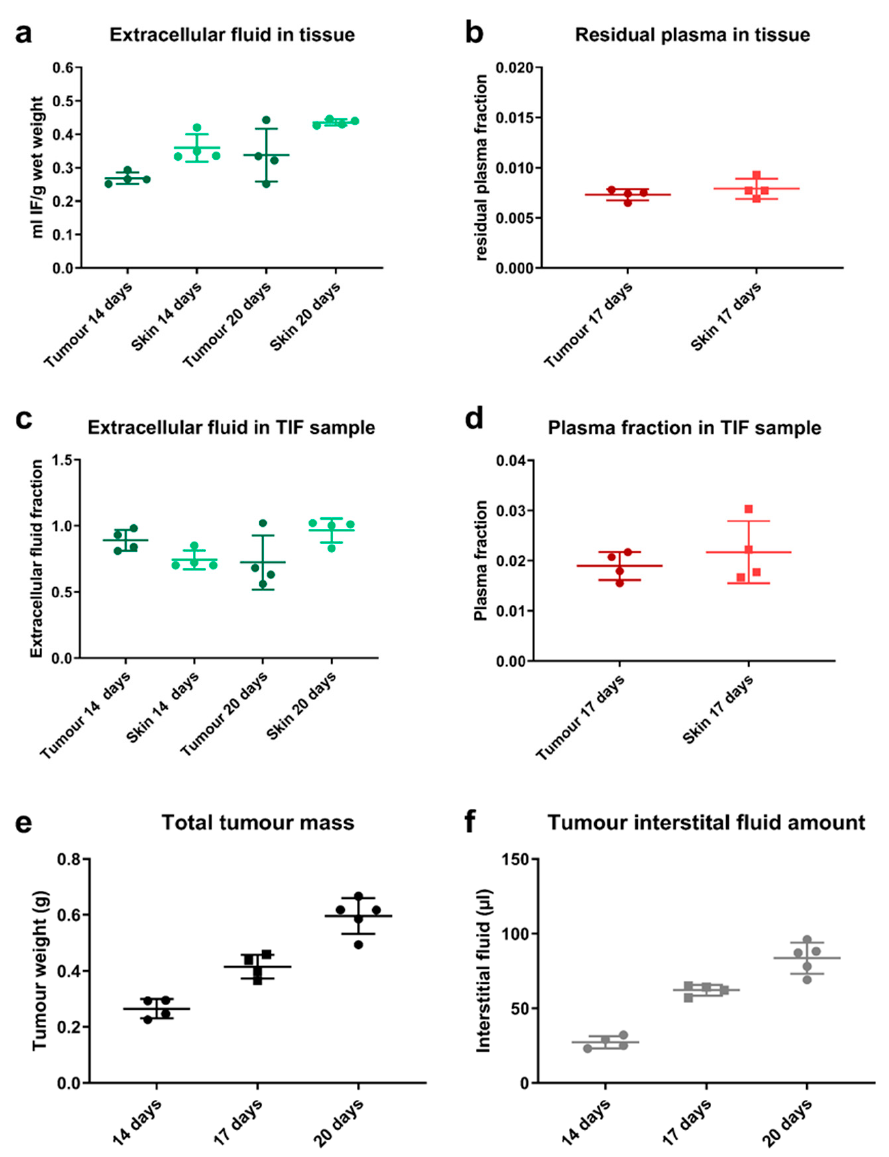
Figure 3. Composition of tissue sample and isolated fluid sample: ( a ) Extracellular volume fraction in tumour and skin sample as measured by 51 Cr-EDTA distribution (1 h after injection) in mice; ( b ) residual plasma volume fraction in harvested tumour and skin tissue as measured by 125 Iodine-HSA distribution (5 min after injection); ( c ) extracellular fluid fraction in the isolated fluid sample from centrifugation of skin and tumour samples and ( d ) plasma contamination, in terms of residual plasma volume fraction, in the isolated fluid sample after centrifugation; ( e ) weight of tumour samples harvested from mice at 14, 17 and 20 days post-engraftment and, ( f ) corresponding tissue fluid sample volumes, which were isolated by centrifugation. Individual data are presented, incl. mean ± SD ( n = 4, n = 5 on day 20).